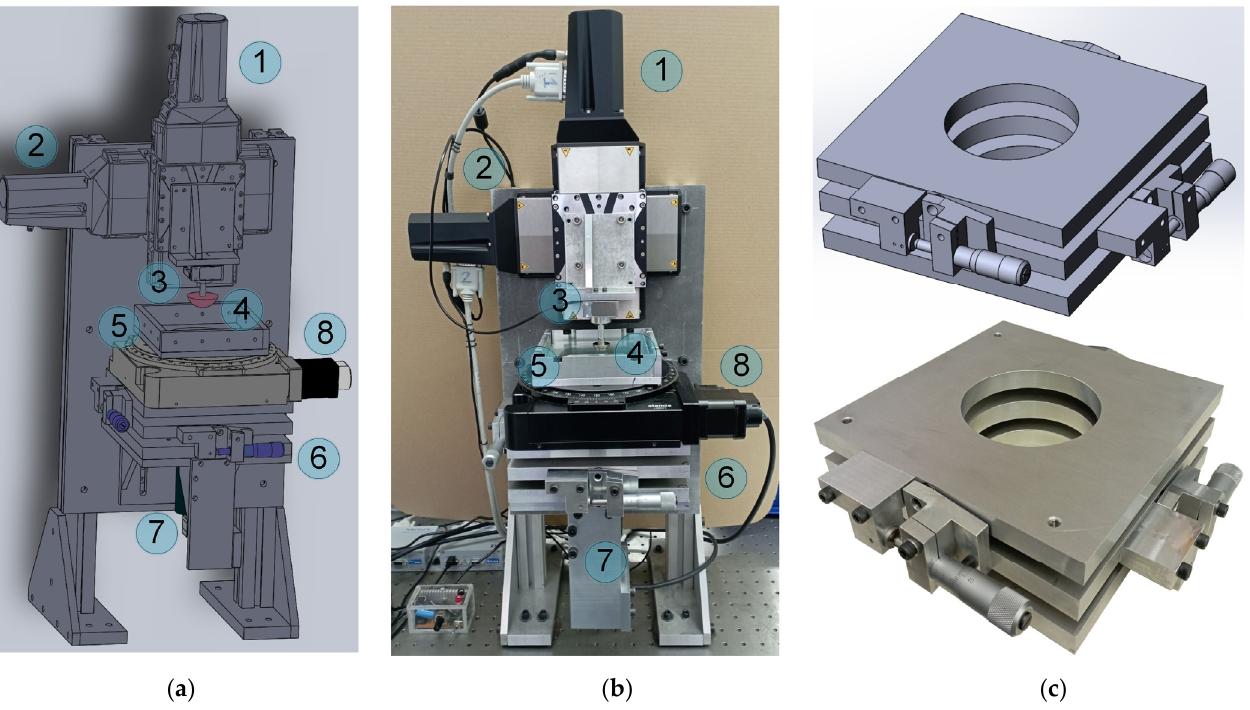
Figure 4. Upgraded version of the device shown in Figure 1. ( a ) Exact 3D model of the facility with an individual blueprint for every part. ( b ) Photo of the assembled and fully operational